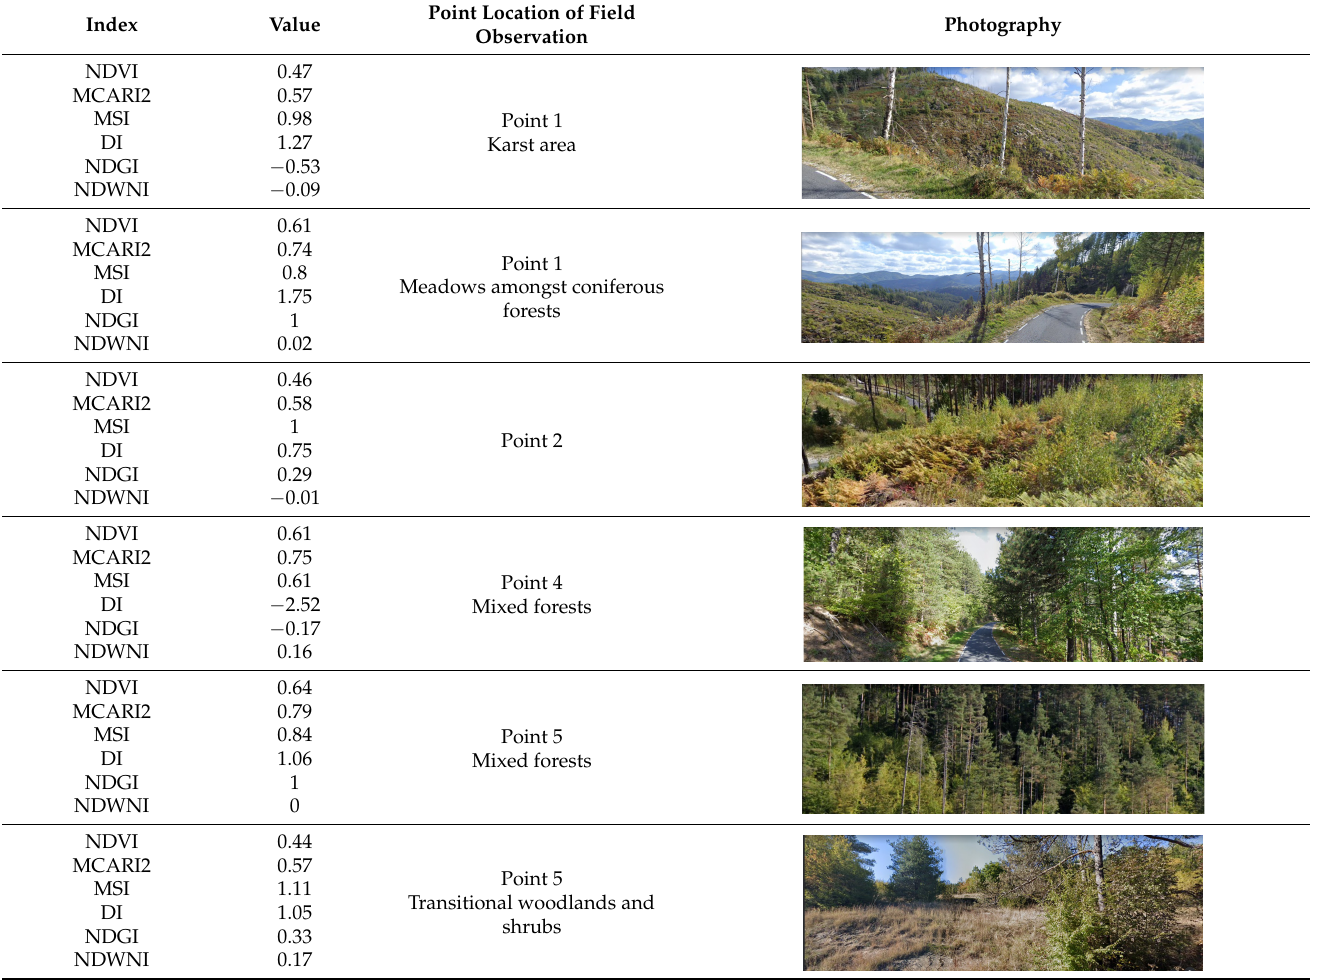
Figure A1. Point locations of field observations. Table A3. Spectral indices values for each location. Interactive three-dimensional panoramas from Google Street view were used to generate photographs.